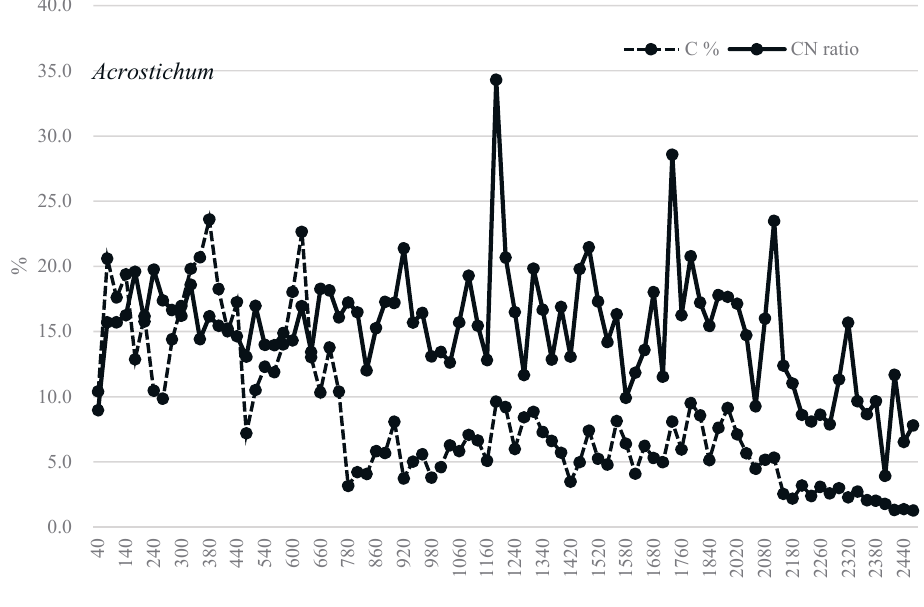
Figure 6. OC contents and C/N ratios in surface soils collected at 5 cm soil depth along the transect. Note that soil from Acrostichum spp. zone had high OC content and C/N ratio was low near the